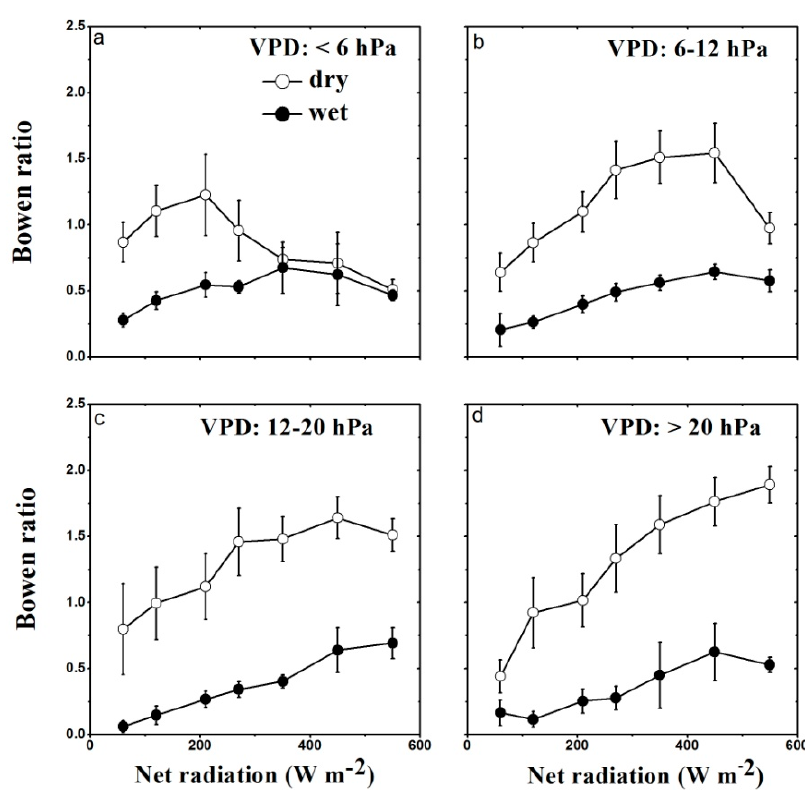
Figure 3. Effects of net radiation on energy partitioning under dry and wet conditions at different VPD levels (( a ) <6 hPa, ( b ) 6–12 hPa, ( c ) 12–20 hPa, ( d ) >20 hPa). Error bars represent the 95% confidence intervals.